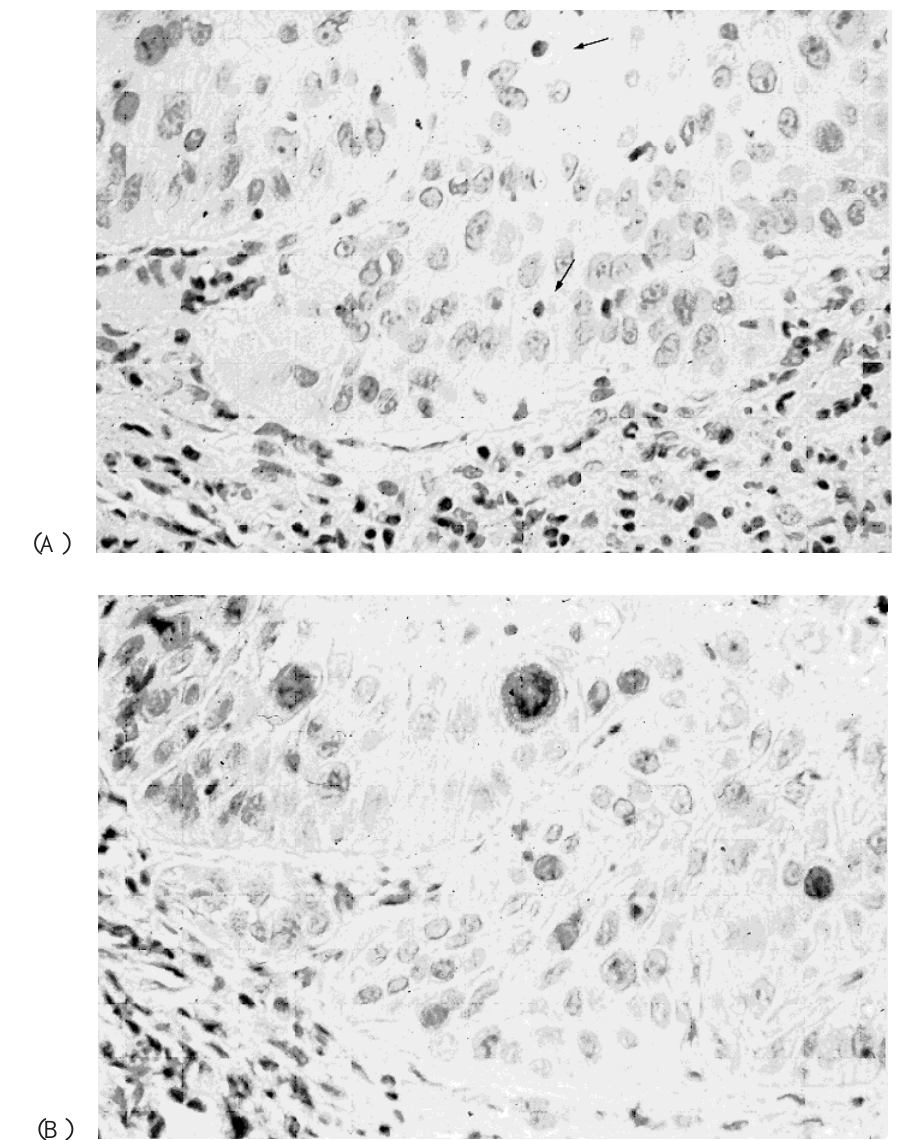
Fig. 2. Immunohistochemical staining of Ki-67 antigen and TUNEL hybridization of cellular apoptosis in a moderatly differentiated carcinoma. At the tumour–stroma interface only very few apoptotic cells are present (arrows) (A), while in the same tumour in corresponding areas the Ki-67 index is markably higher (B). (Magnification ×